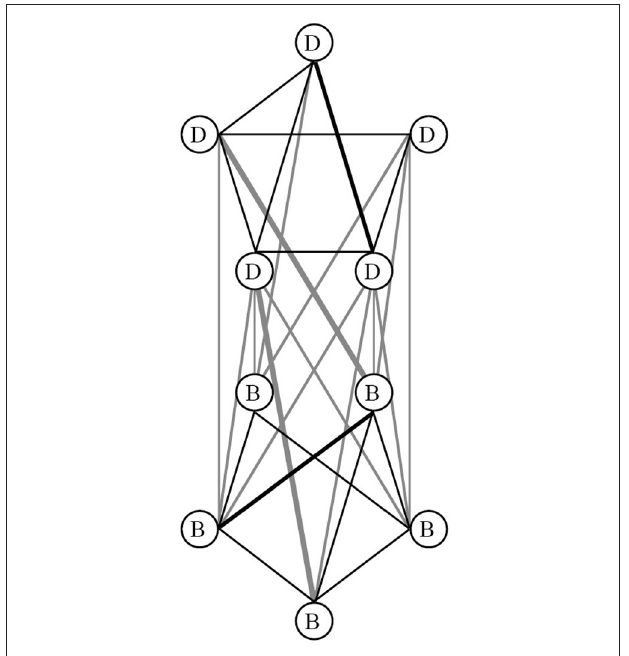
FIGURE 1 | An illustration of the network approach on the comorbidity of depression symptoms (D) and borderline personality disorder symptoms (B). The network model hypothesizes associations between the symptoms of borderline personality disorder (B) and major depressive disorders (D). Some relations between symptoms are stronger than others [illustrated by the thickness of some lines